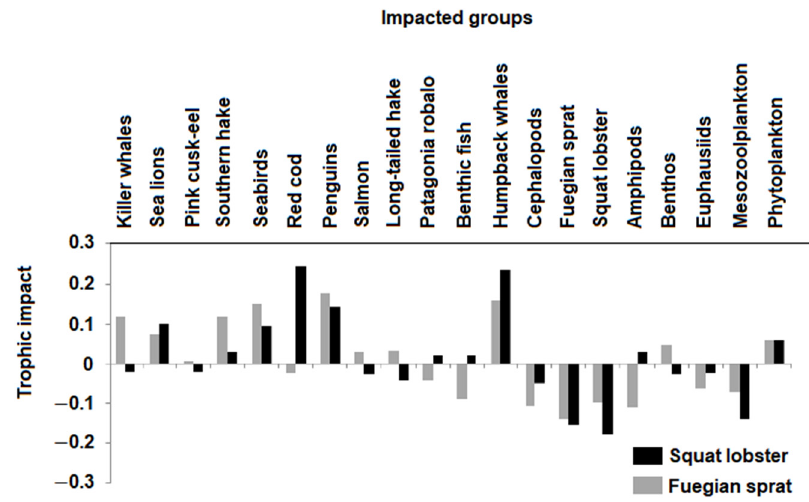
Figure 3. Trophic impacts exerted by the squat lobster (black bar) and the Fuegian sprat (gray bar) on the other functional groups of the Francisco Coloane ecosystem, Magellan Strait.